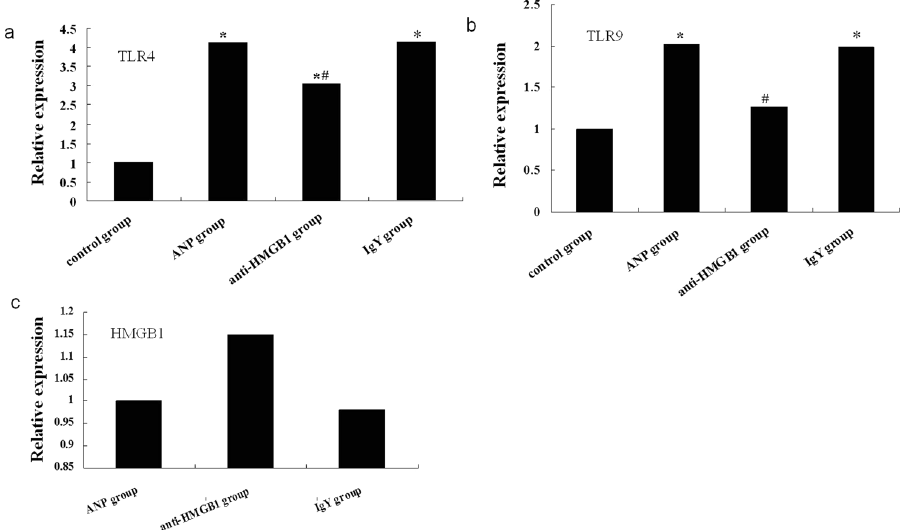
Figure 7. Anti-HMGB1 antibody treatment suppresses the elevated expressions of TLR4, TLR9 mRNA. ( a ) Detection of TLR4 mRNA expression by real-time PCR. Actin was used as a house-keeping gene. Relative expression differences of mRNA were normalized to endogenous actin expression and calculated using the 2 − ∆∆ CT method. ( b ) Detection of TLR9 mRNA expression by real-time PCR. ( c ) Detection of HMGB1 mRNA expression by real-time PCR. * P < 0.05 versus control group. # P < 0.05 versus ANP group.